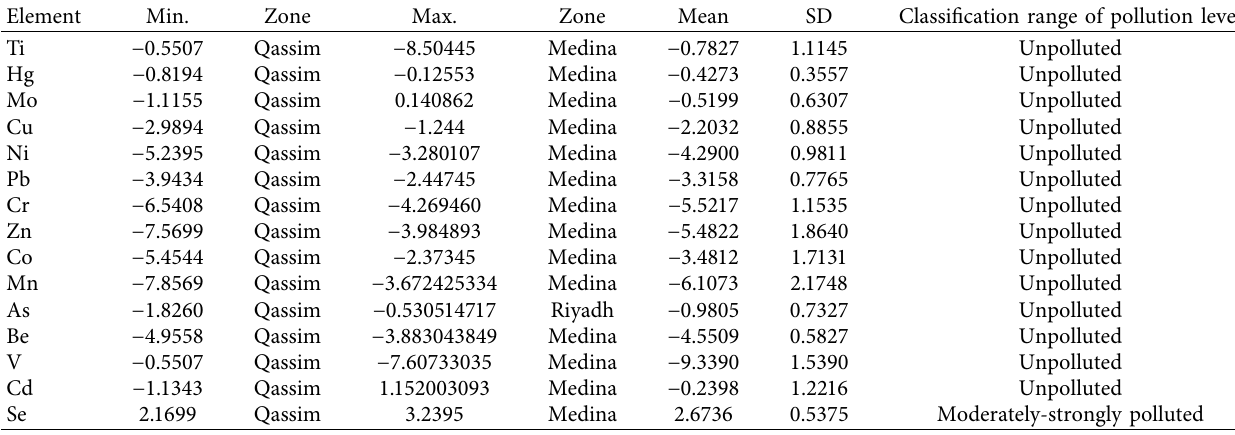
geo ) of Riyadh, Qassim, and Medina regions. Soil treated with sewage water.